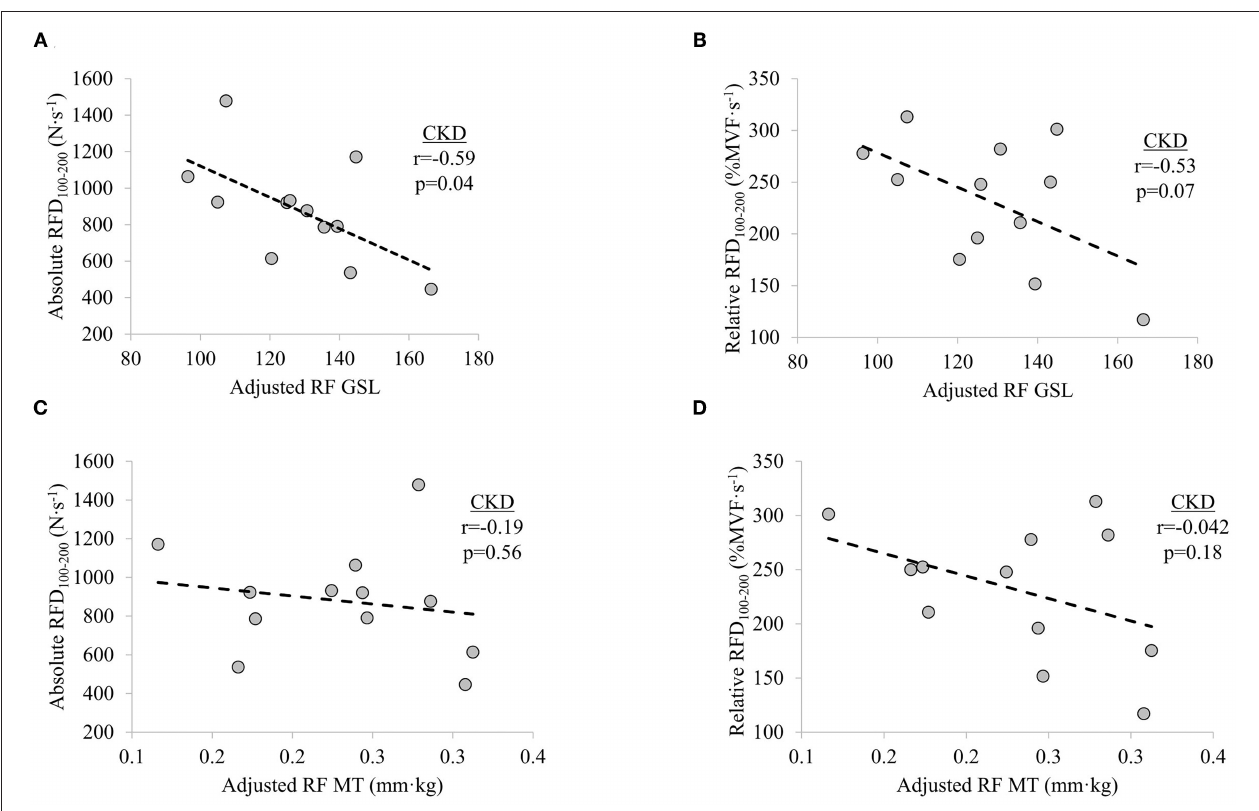
FIGURE 3 | Relationships between (A) knee extensor absolute rate of force development (RFD) at time interval 100–200ms (RFD 100 − 200 ) and adjusted rectus femoris grayscale (RF GSL), (B) relative RFD 100 − 200 and adjusted RF GSL, (C) absolute RFD 100 − 200 and adjusted RF muscle thickness (MT), and (D) relative RFD 100 − 200 and adjusted RF MT in patients with chronic kidney disease (CKD) stages 3b and 4 not on dialysis. Significance level set at p ≤